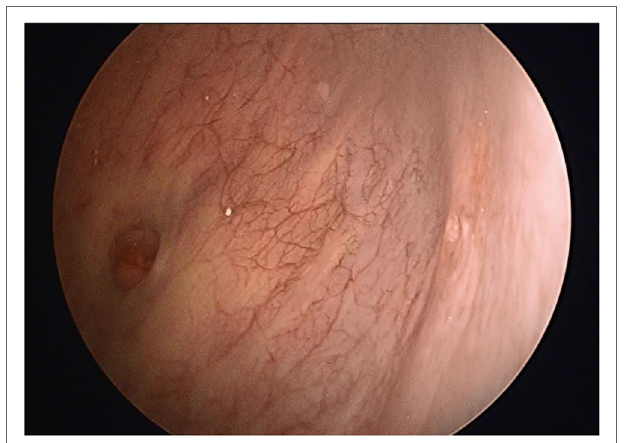
FIgURe 1 | Cystoscopic view of the vesicouterine fistula on the right and the left ureteral ostium on the